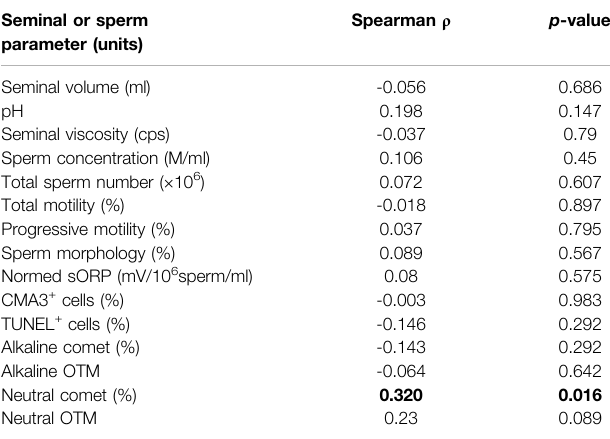
TABLE 3 | Results from the correlation analyses between alpha diversity and seminal and sperm parameters. Seminal or sperm parameter (units)